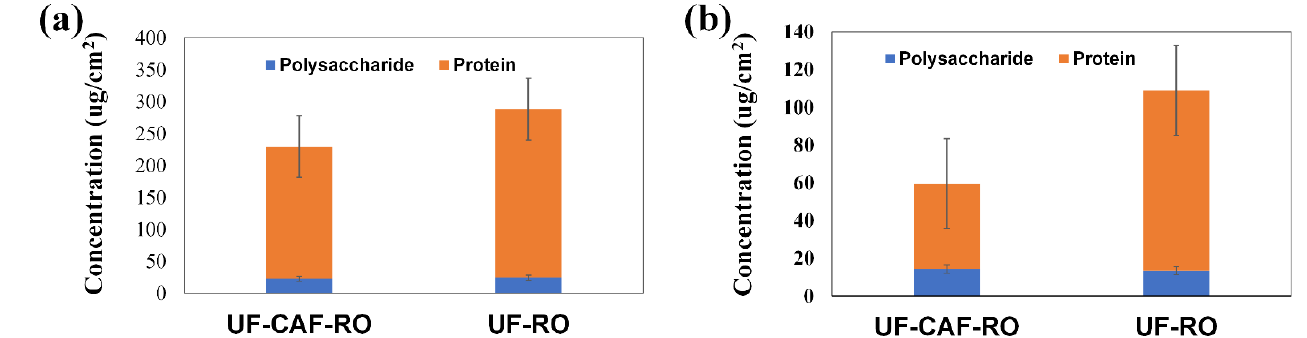
Figure 5. EPS content of the RO membranes with and without CAF pre-treatment in the ( a ) 1st evaluation and ( b ) 2nd evaluation.